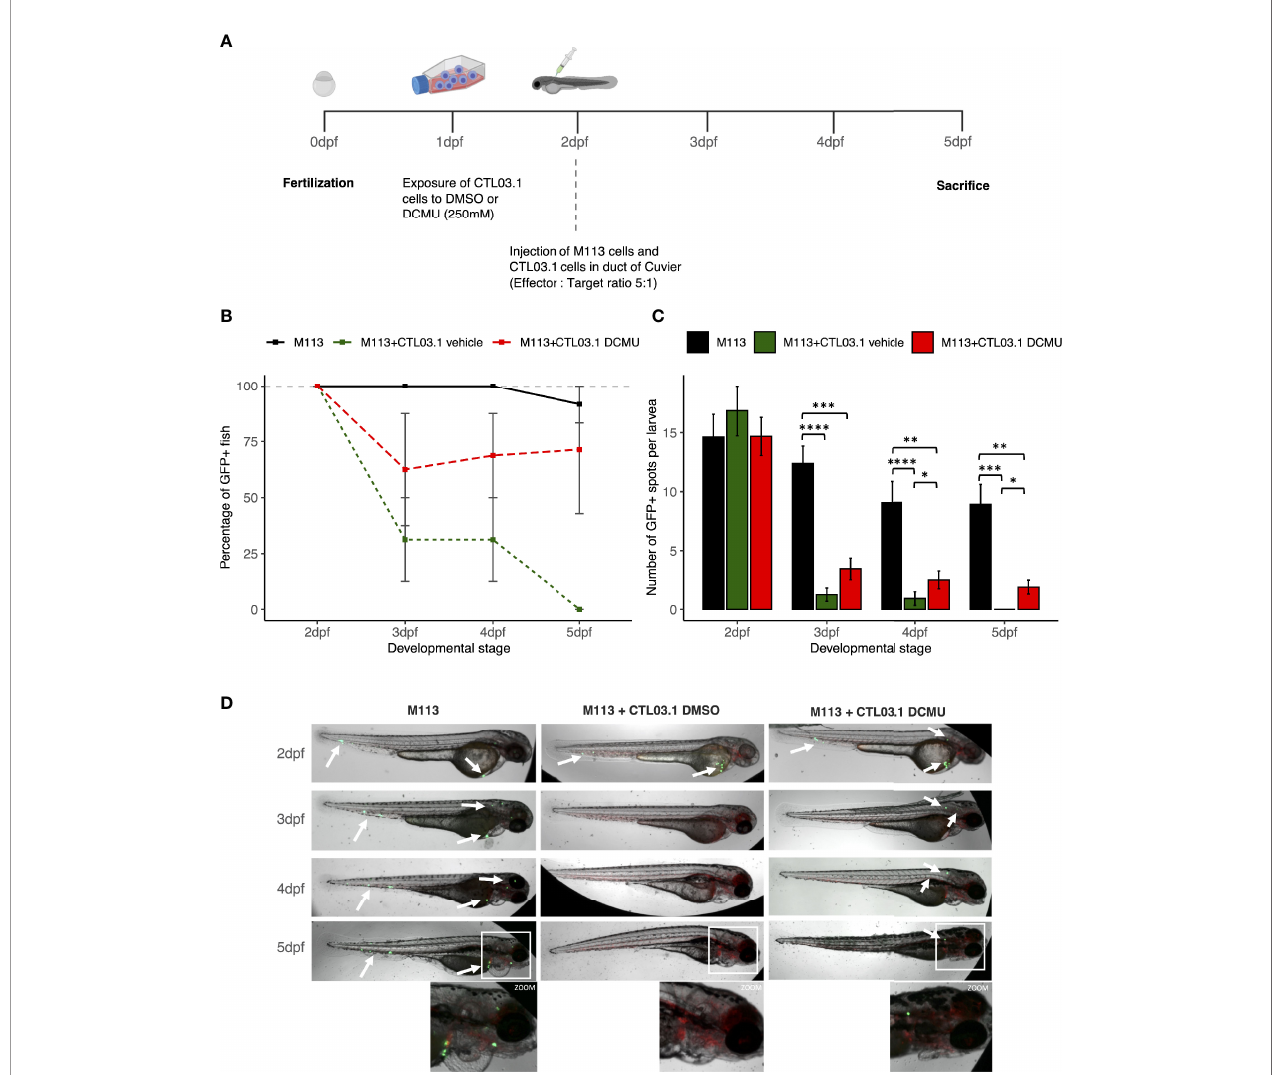
FIGURE 5 | DCMU exposures create a permissive environment to tumor development. (A) Schematic diagram of the experimental design. (B) Percent of GFP+ larvae. In black, zebra fi sh injected with M113 cells alone, in dark green, zebra fi sh injected with M113 and CTL03.1 cells exposed to vehicle and in red, zebra fi sh co- injected with M113 and CTL03.1 cells exposed to DCMU (250 µM). (C) Quanti fi cation of GFP+ spots per larvae. In black, zebra fi sh injected with M113 cells alone, in darkgreen, zebra fi sh co-injected with M113 and CTL03.1 cells exposed to vehicle and in red, zebra fi sh co-injected with M113 and CTL03.1 cells exposed to DCMU (250 m M). (D) Representative lateral view of zebra fi sh larvae bearing M113 cells (green) in the three groups. Zoom 2.5 x. Mean of 3 independent experiments, n=8 larvae per group, per experiment. Statistical signi fi cance. * p ≤ .05, ** p ≤ 0.01, *** p ≤ 0.001. **** p ≤